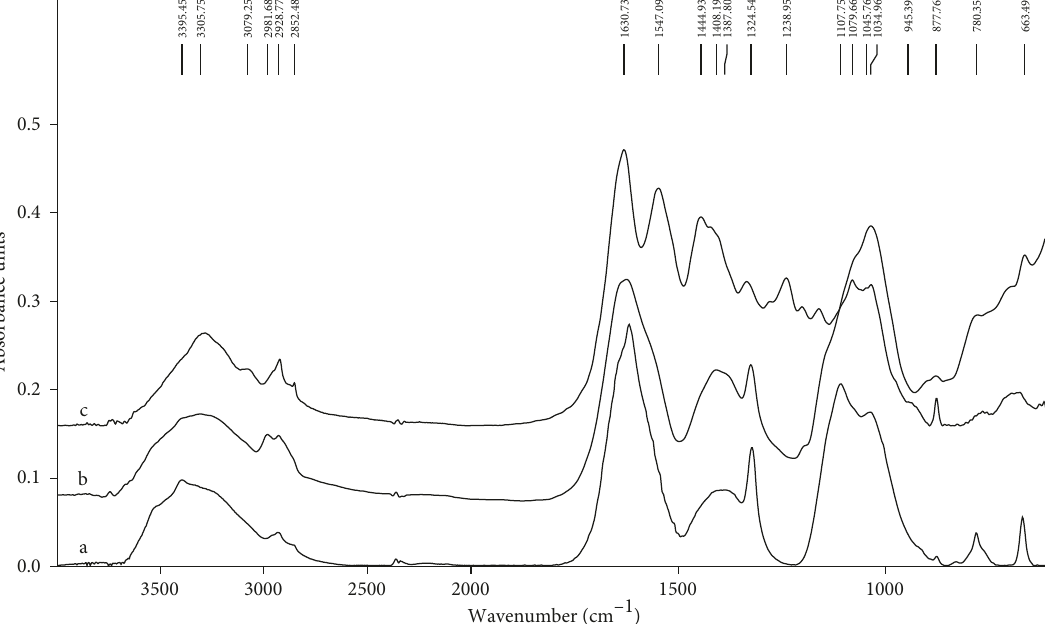
Figure 4: ATR-FTIR spectra of two black inked areas: (a, b) Parch. 37 and (c) related